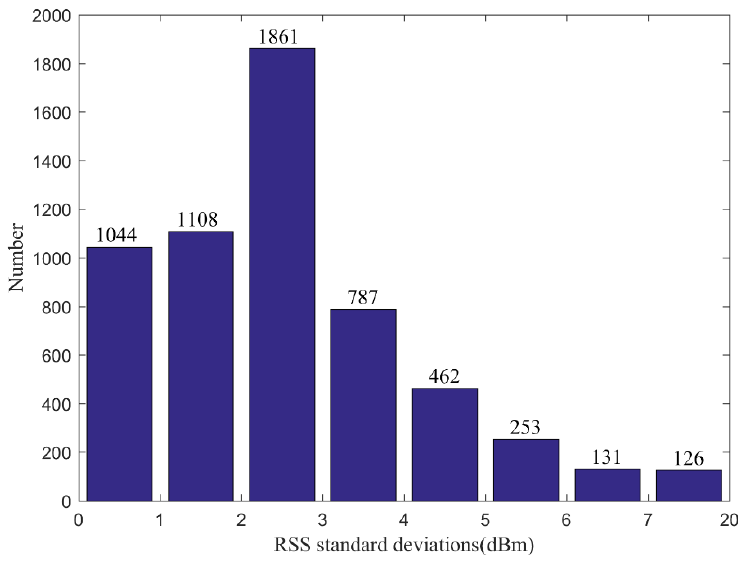
Figure 6. The statistics of RSS standard deviation values at 352 RPs.